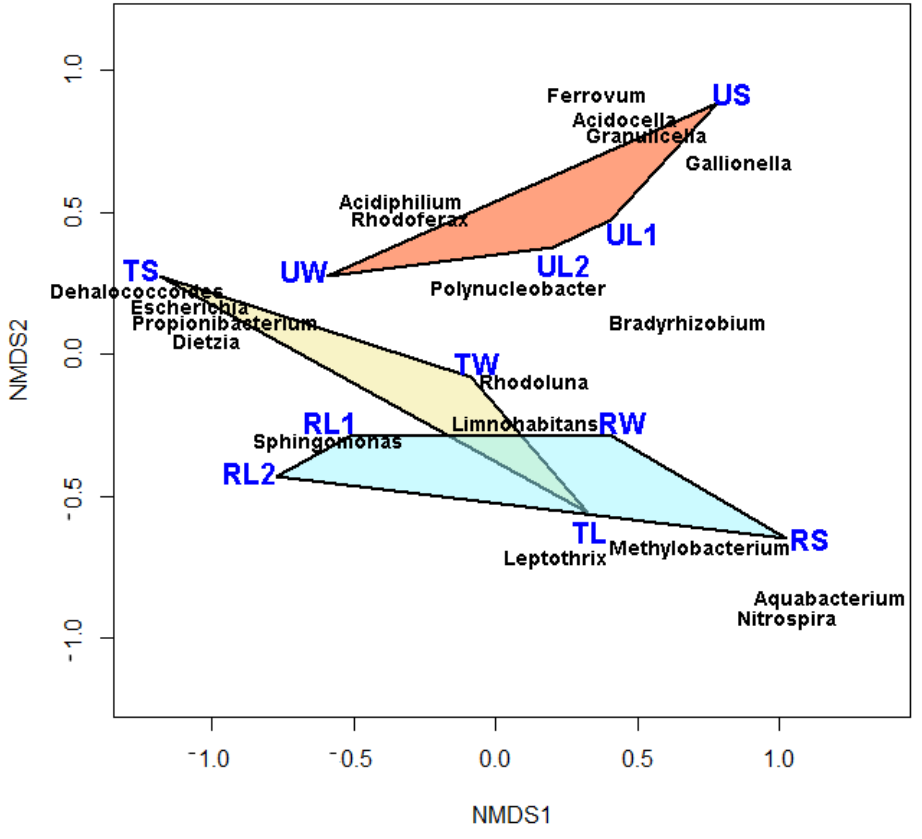
Figure 1. NMDS ordination biplot for microbial communities from 3 types of habitats at 3 sites along an AMD gradient. Stress = 0.10. Only the most abundant genera are shown. Community codes: U = untreated site; T = treated site; R = reference site; W = water habitat; L = leaf habitat; S = sediment habitat; 1 and 2 indicate replicate samples. Communities from the 3 habitats are connected for each respective site. Table 2. Relative abundance heat map of the most-abundant-classified genera in microbial communi- ties in water, on leaves and in sediment at 3 sites comprising an AMD gradient (values were averaged for replicates from the same community). Colors indicate magnitude of values: green = lowest, yellow = 50th percentile, and red = highest. Shannon Diversity and richness are given for each community. U = untreated site; T = treated site; R = reference site; W = water habitat; L = leaf habitat; S = sediment